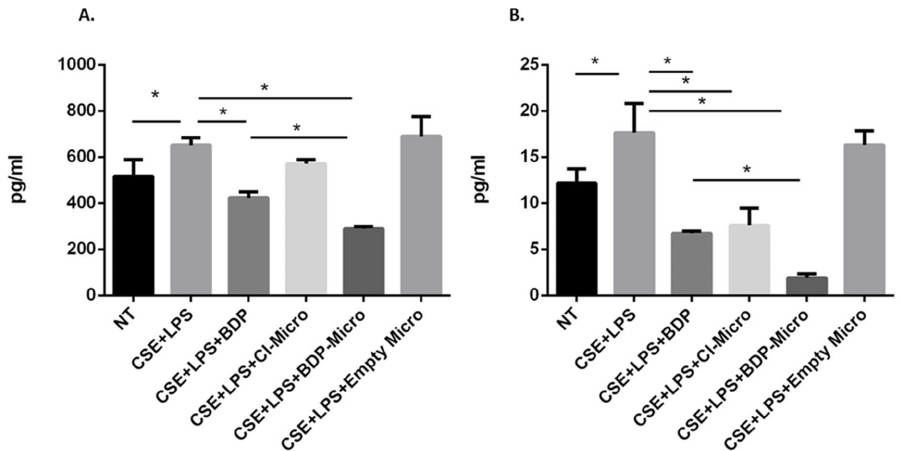
Figure 7. IL-6 release in 16HBE and A549 cells. 16HBE ( A ) and A549 ( B ) cells were incubated for 24 h with either free BDP in dispersion (BDP), with empty particle (Empty Micro) or BDP incorporated into the MP systems (CI-Micro or BDP-Micro) (10 −8 M) and CSE 10% and LPS 1 µg/mL. The drug (free or entrapped into MP samples) was added 1 h before CSE and LPS cells stimulation, then the supernatants were collected for evaluation of IL-6 release by ELISA method assays. Mean values ± standard deviations (error bars) are reported ( n = 5). * p < 0.05 ANOVA (Bonferroni).